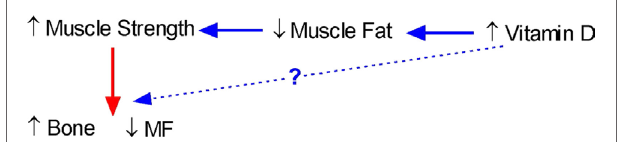
FiGURe 2 | Conceptual model of the interrelationship between bone, fat, and muscle and the role of vitamin D . An increase in vitamin D should lead to a decrease in muscle fat leading to an increase in muscle strength and a subsequent increase in bone and simultaneous decrease in marrow fat (MF). However, there is also the possibility that increases in vitamin D will also directly lead to an increase in